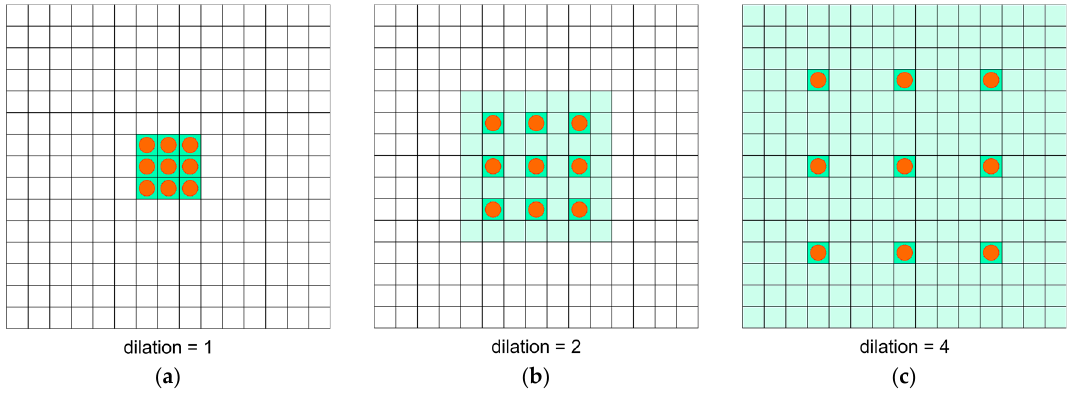
Figure 5. Convolutional 3 × 3 operation with different dilation rates: ( a )—1, ( b )—2, ( c )—4. Orange circles, filter kernel points; green area, contextual image information that might be taken into consideration.